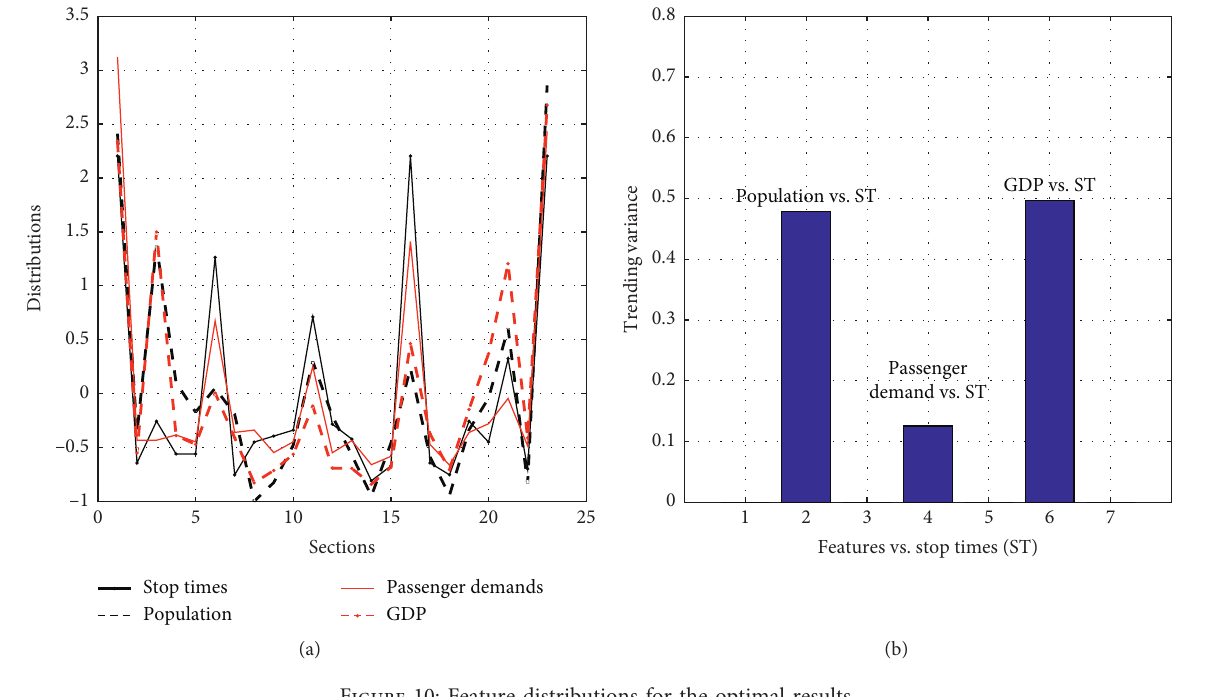
Figure 10: Feature distributions for the optimal